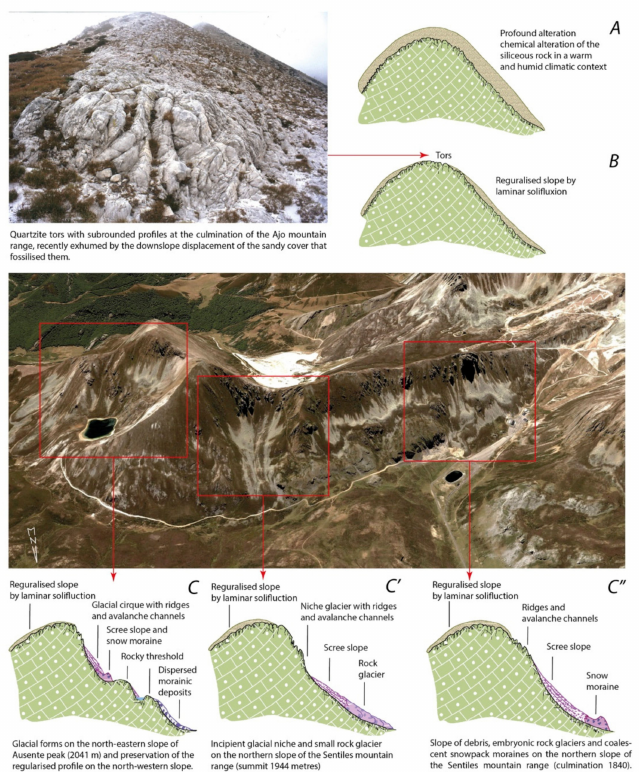
Figure 6. General view of the northern slope of the Sentiles mountain range (Google Earth image from 2007), showing the different glacial and periglacial landforms and surface formations and hypotheses about their evolution. Photograph and schemes by the